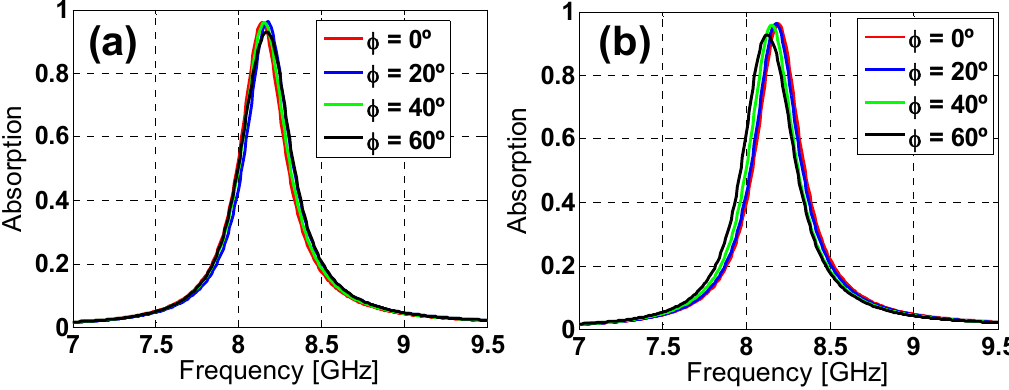
Figure 3. Hexagon design absorption simulation results for different polarization angles ( ϕ ) of the incident field for both ( a ) TE and ( b ) TM polarizations.